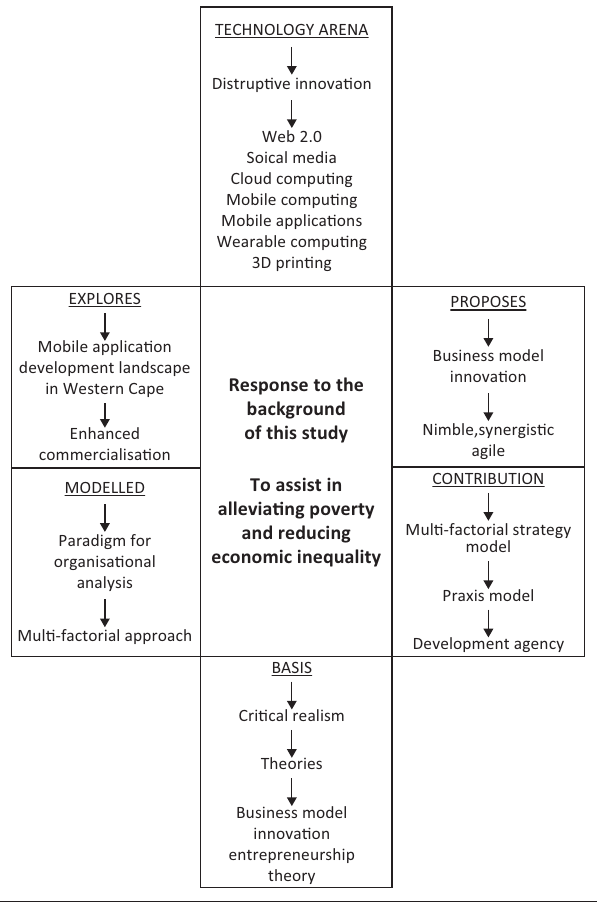
FIGURE 1: A graphical representation of the research design of this